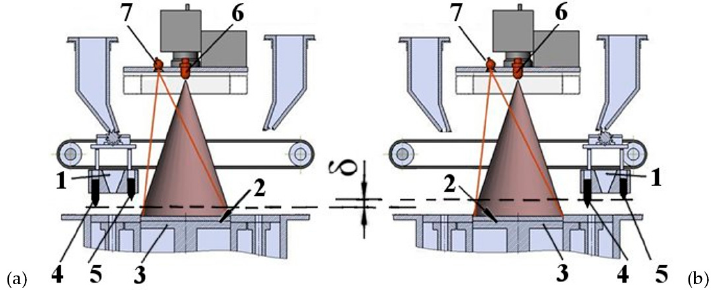
Figure 7. Schematic drawing of the recoater alignment control system of the SLS machine: ( a ) application of powder layer from the left limit position, ( b ) application of powder layer from the right limit position. Designation of numbers: 1—double-knife recoater; 2—upper surface of the platform; 3—platform; 4—left knife; 5—right knife; 6—top heaters; 7—pyrometer.